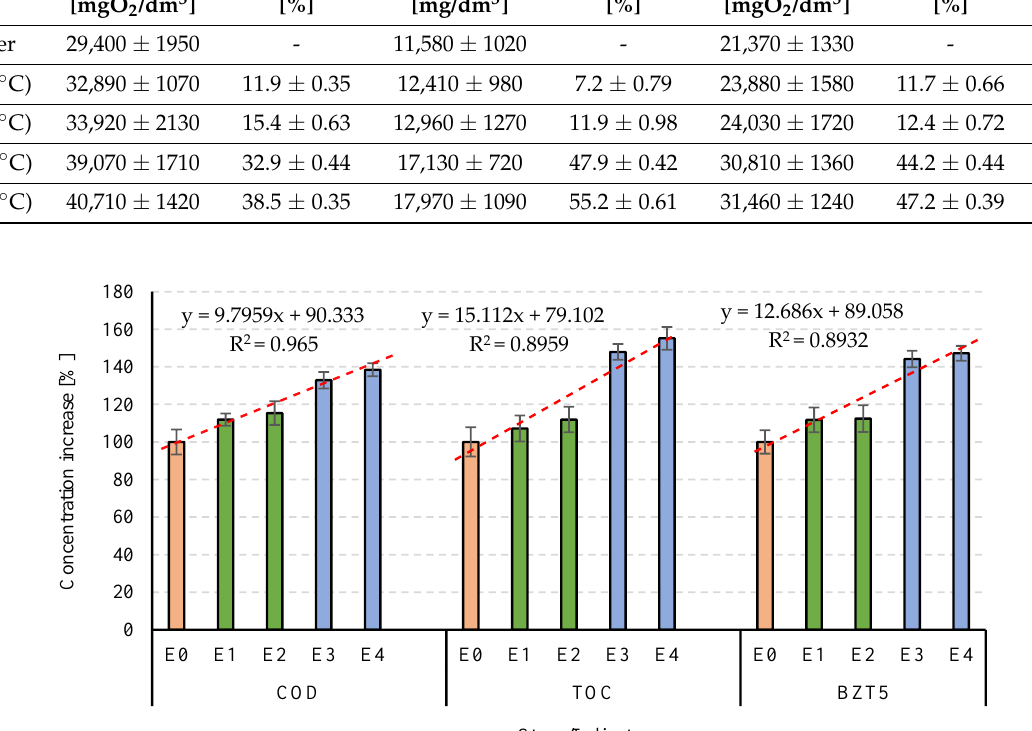
Figure 1. Effect of thermal pre-treatment method on the percentage increase in the concentration of organic compounds.